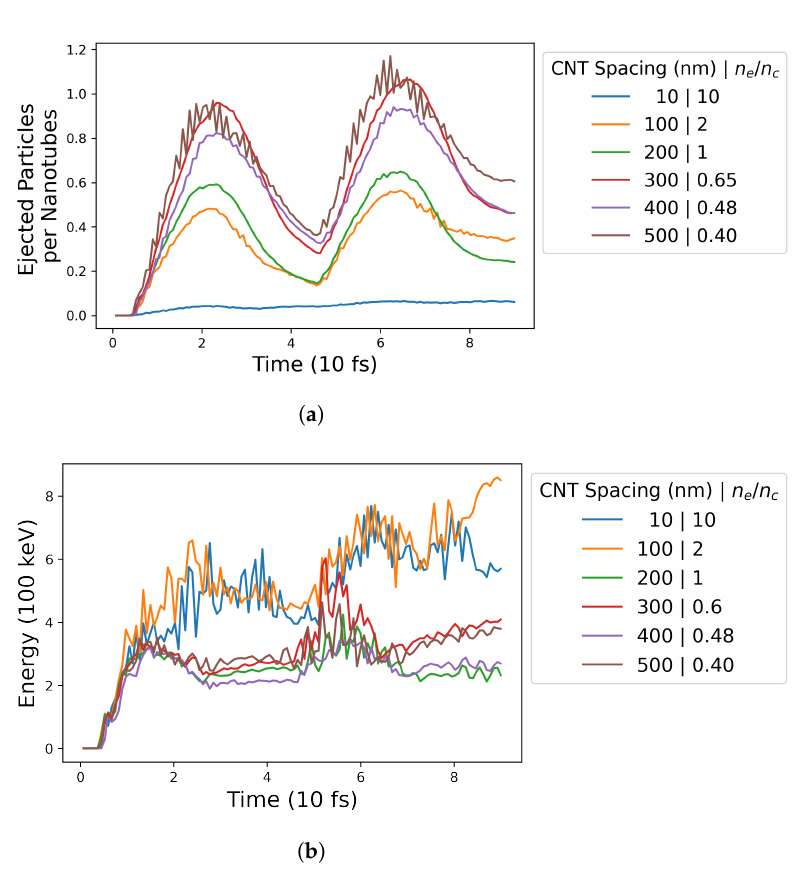
Figure 10. Number of extracted electrons ( a ) normalized to total number of CNTs in the simulation as a function of time and maximum energy of electrons ( b ) over simulation time for various values of CNT spacing. The first laser reaches CNTs in the first few femtoseconds. The second laser reaches the CNTs at around 45 fs. The laser intensity is a 0 =